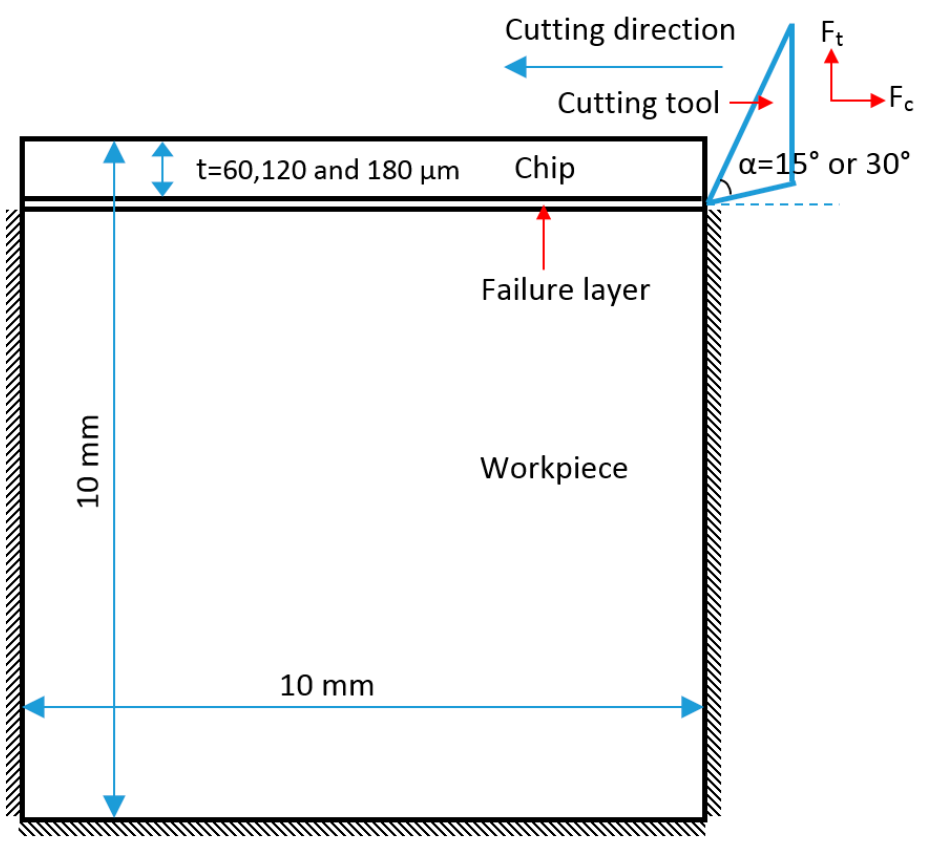
Figure 3. Schematic of geometry and boundary conditions in FE analysis.